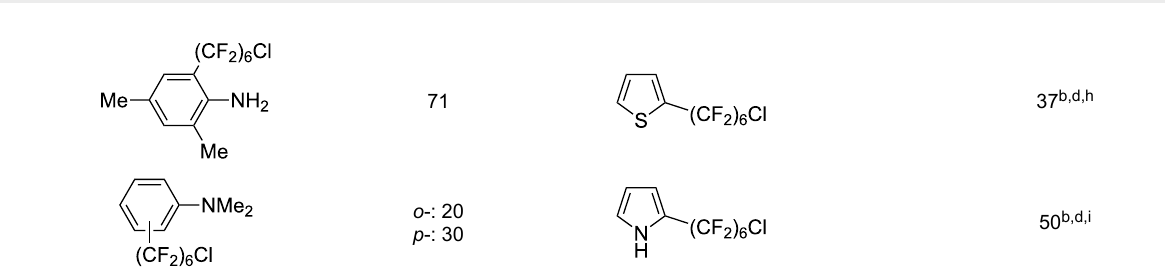
Table 35: Ni-catalyzed perfluoroalkylation of anilines, benzene, furan, thiophene and pyrrole using ω -chloroperfluoroalkyl iodides [109,110]. (continued)